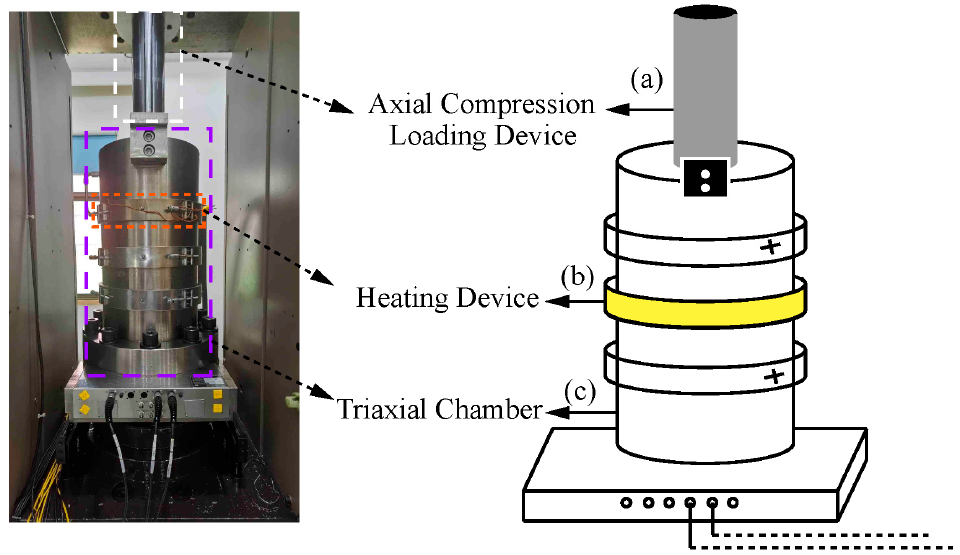
Figure 4. Triaxial chamber, axial load device, and heating device.